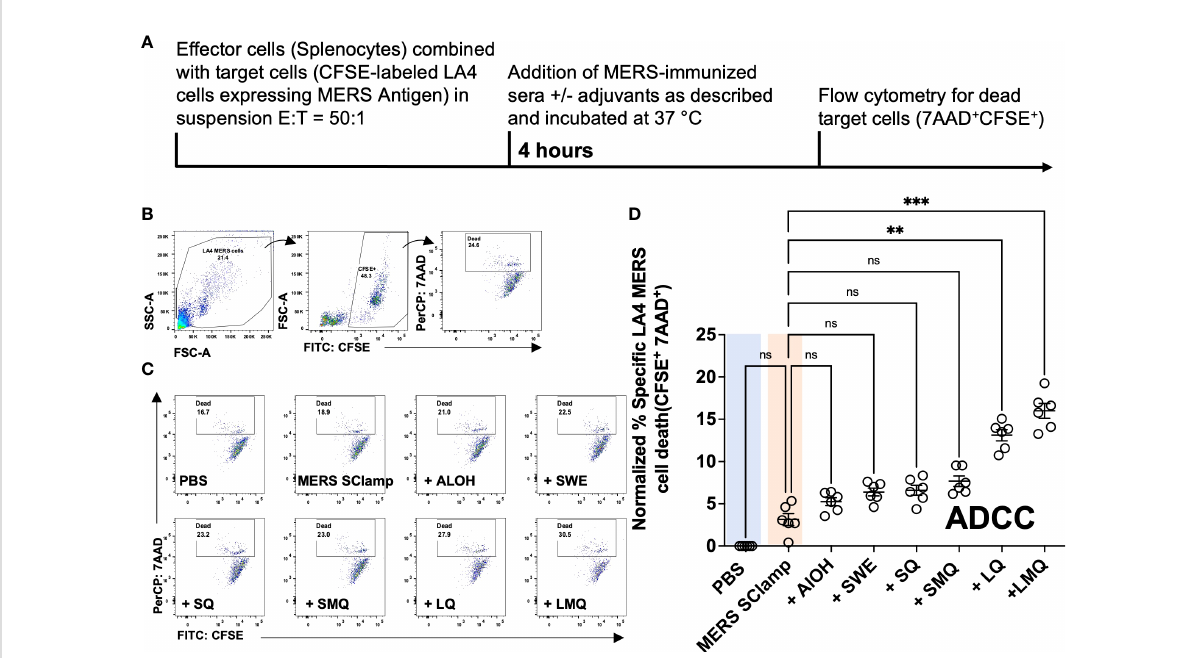
FIGURE 3 Vaccine-induced antibody responses vary with potential for ADCC induction. (A) ADCC assay experimental protocol. (B) Gating strategy for ADCC assay in which CFSE-labeled mouse LA4 MERS cells were incubated with BALB/c splenocytes (E:T = 50:1) and serum from mice immunized with MERS SClamp antigen +/- indicated adjuvants for 4-hours. Gating on live cells of LA-4 cell morphology, cell death (7AAD + ) was measured among CFSE + cells. (C) Representative fl ow cytometry plots of the proportion of dead LA4 MERS cells (CFSE + 7AAD + ) for each condition. (D) Data summary, where experimental data have been normalized to the mean percentage cell death of the PBS control condition. Data presented as normalized individual data points with mean +/- SEM. Kruskal-Wallis with Dunn ’ s test, ns = P>0.05, **P<0.01, ***P<0.001. Experiment completed once, n = 6 mice/group. Related to Figure